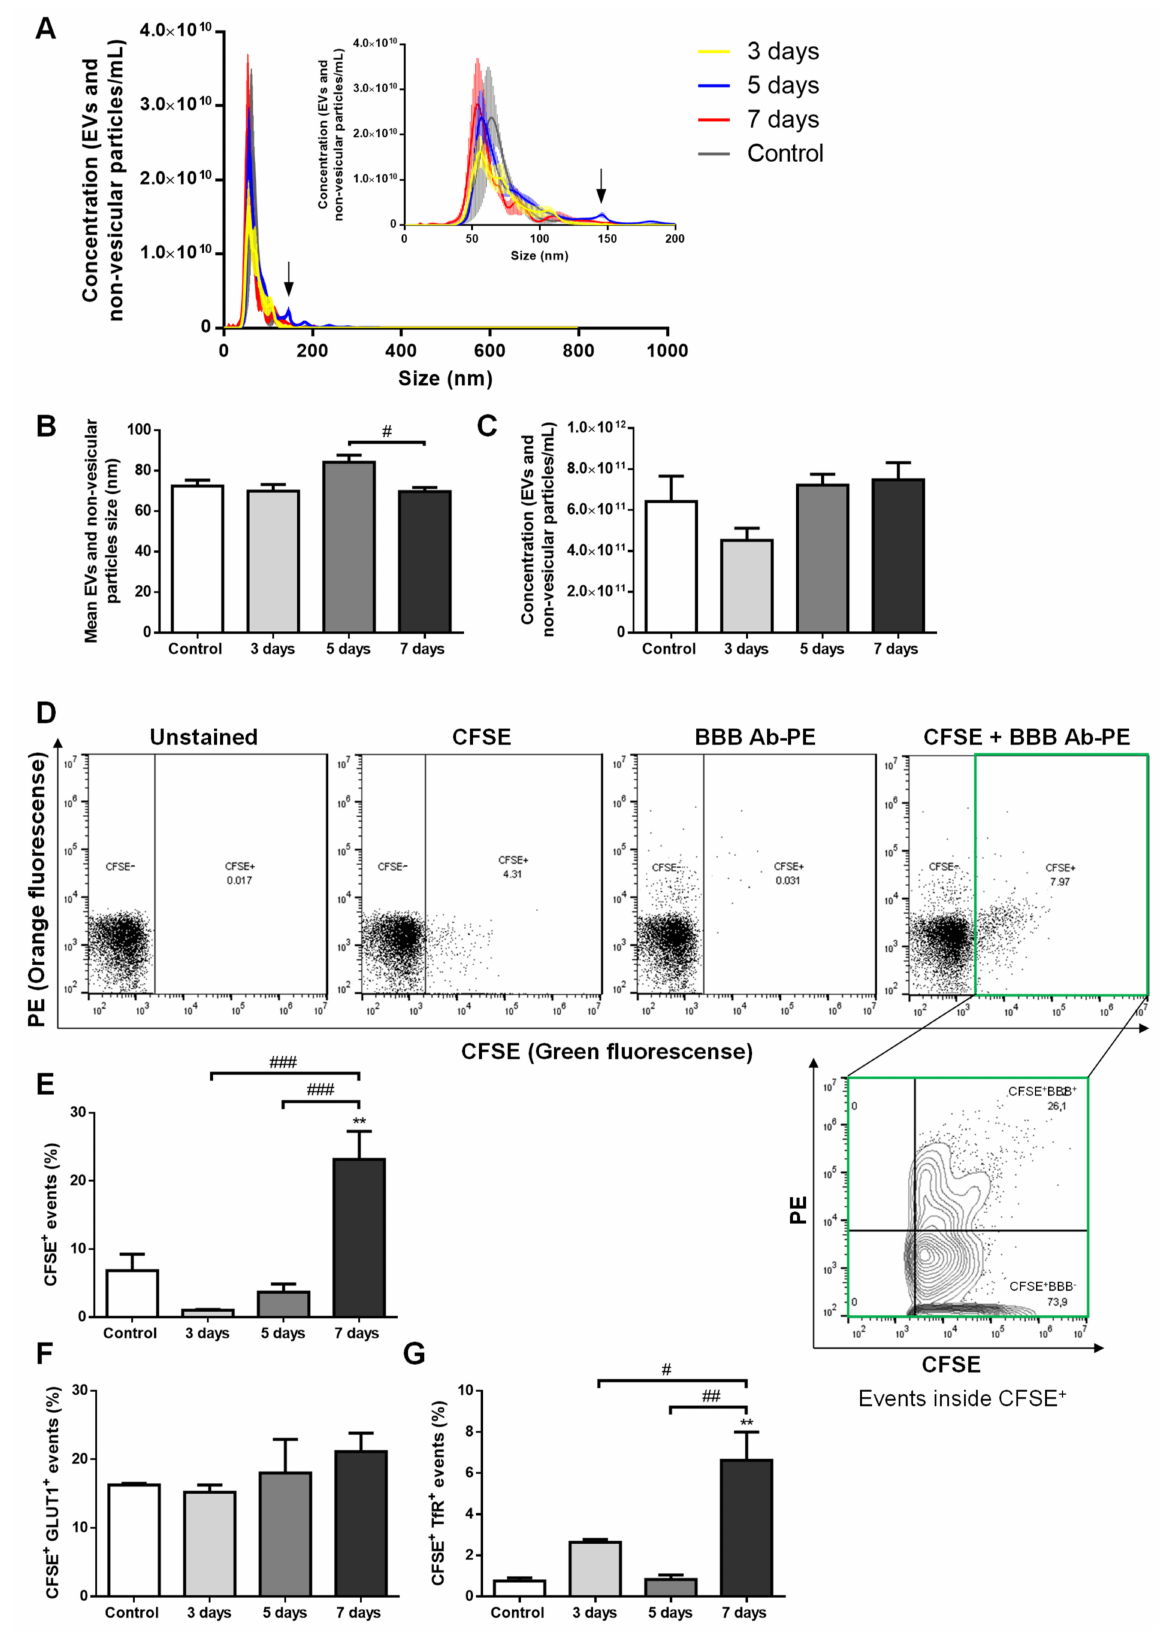
Figure 1. Extracellular vesicles (EVs) are released by brain microvascular endothelial cells in advanced stages of breast cancer brain metastases (BCBM) formation. 4T1 cells or vehicle (control) were inoculated into the carotid artery of